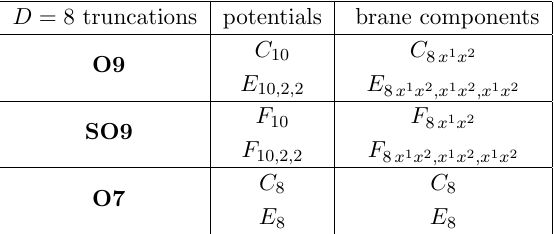
Table 4 . The Z 2 truncations of the maximal theory in D = 8 from the IIB perspective. The indices x i , i = 1 ; 2, label the internal